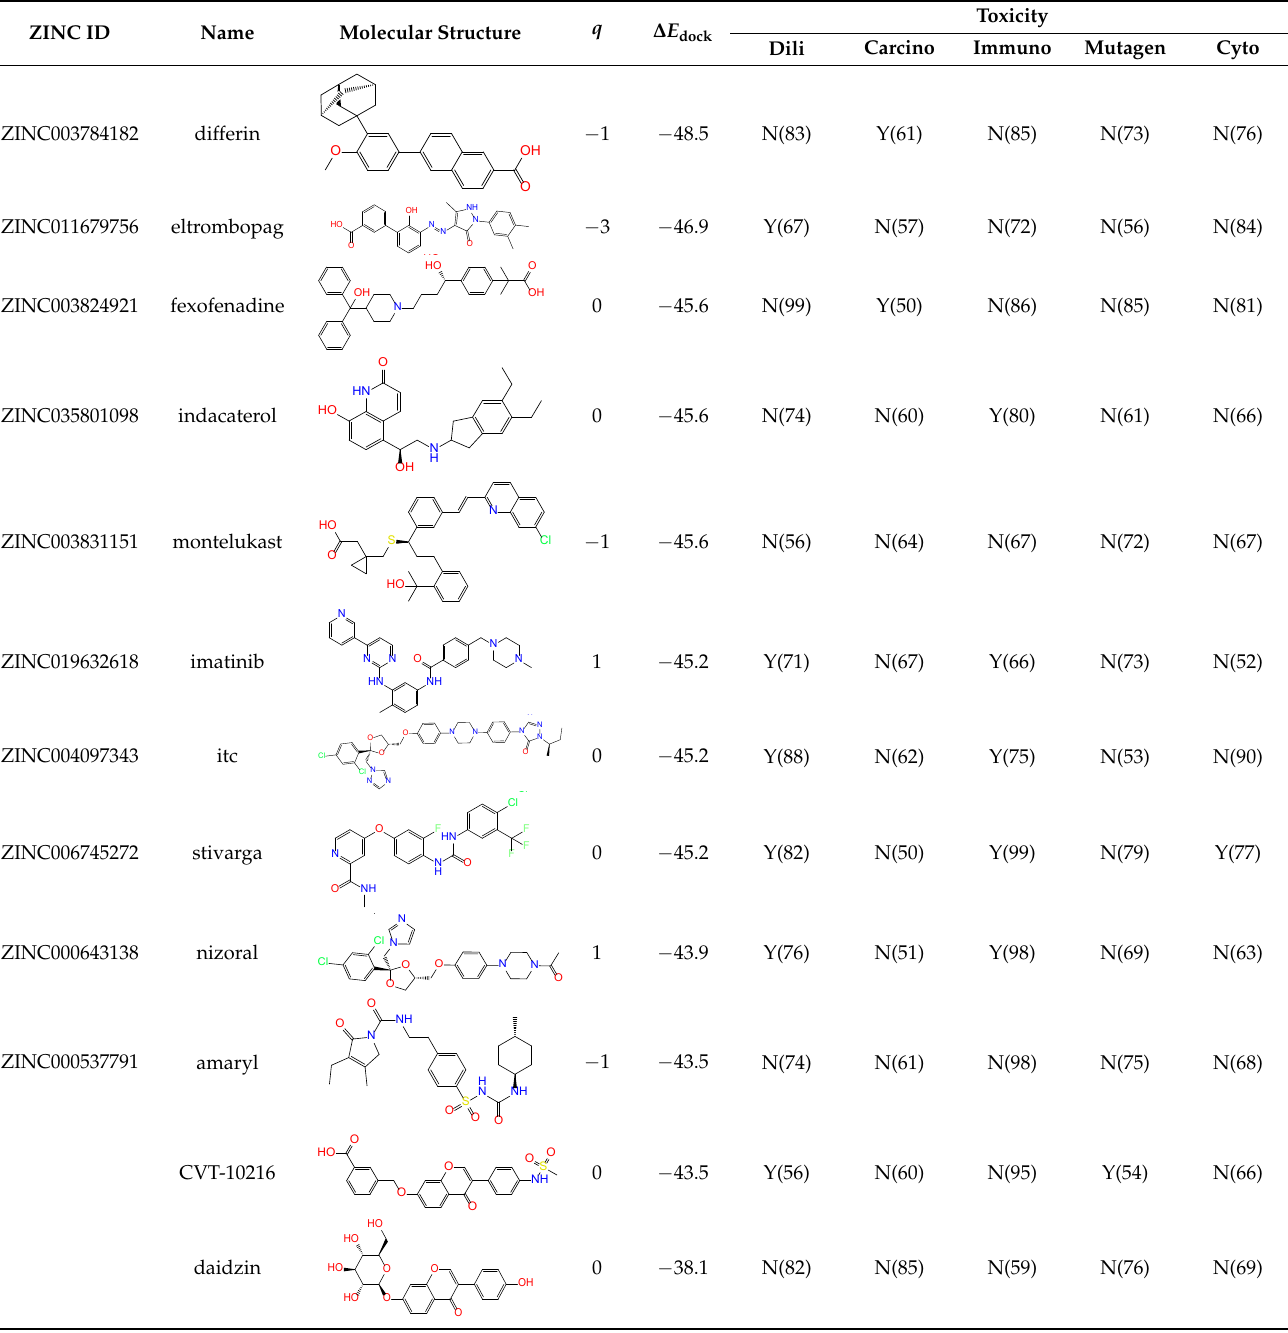
Table 1. Top 10 compounds from virtual screening of FDA-approved drugs via Autodock Vina using the crystal structure of ALDH2 as receptor and the toxicity prediction via ProTox-II.